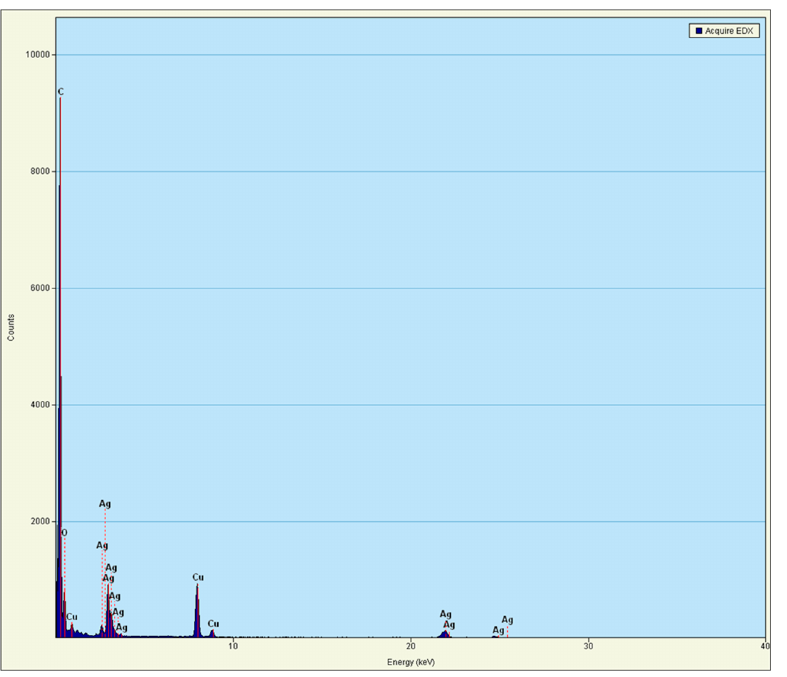
Figure 3. Energy Dispersive Absorption photograph (EDXA) of AgNPs produced by Streptomyces aizuneusis ATCC 14921.